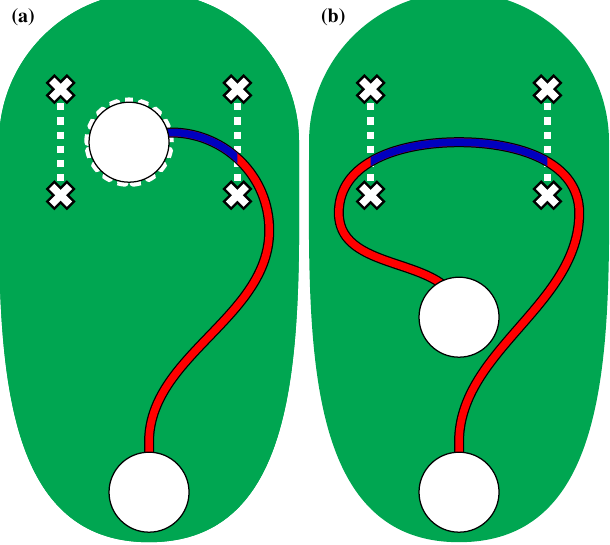
¯ Z FIG. 12. The deformation of the T operator under the fault- tolerant entangling operation. (a) The logical operator that terminates at the hole moves with the hole and is thus threaded between the twists. We also point out that the boundary of the hole changes from a rough boundary to a smooth boundary as it is passed across the defect line. As such, we draw a white dashed line around the puncture. (b) Upon moving the puncture back to its initial position, we see that we have wrapped the logical string operator around the lower two twists shown in the figure. One can ¯ Z ¯ Z check that the deformed logical operator is equivalent to C T , as shown in Fig.